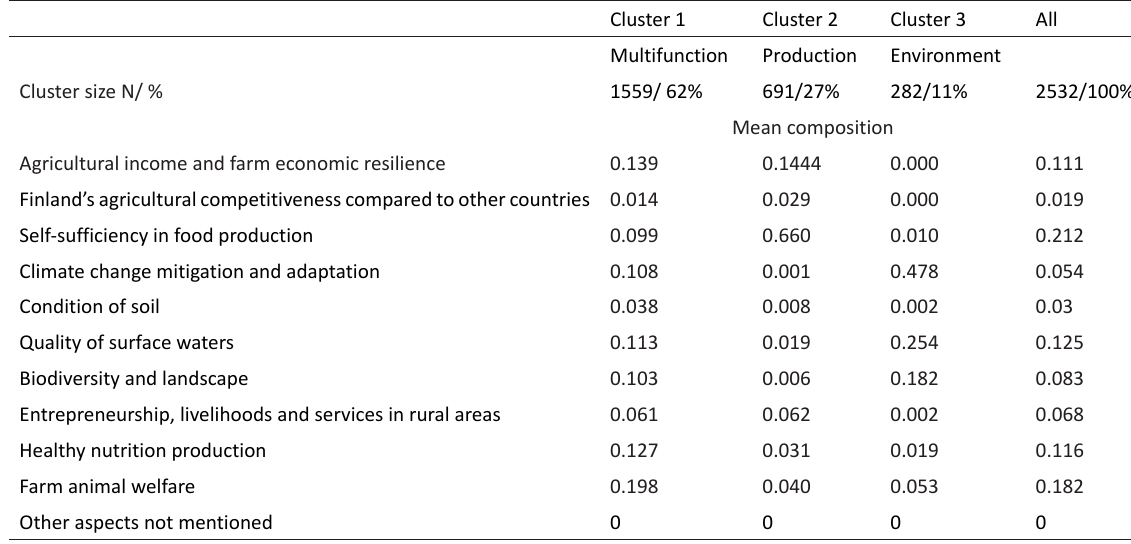
Table 5. Mean composition of budget allocation in the